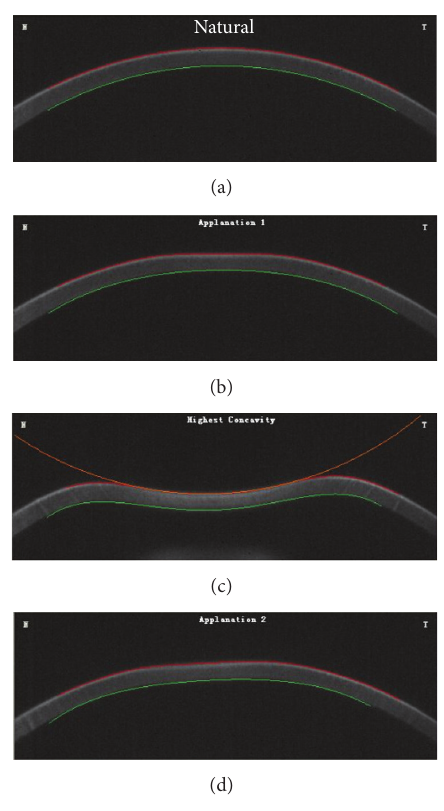
Figure 1: The corneal deformation processes during air puff from CorVisST.Duetotheairpuff,thecorneastartswithanaturalconvex shape and undergoes three distinct phases, first applanation, highest concavity, and second applanation,